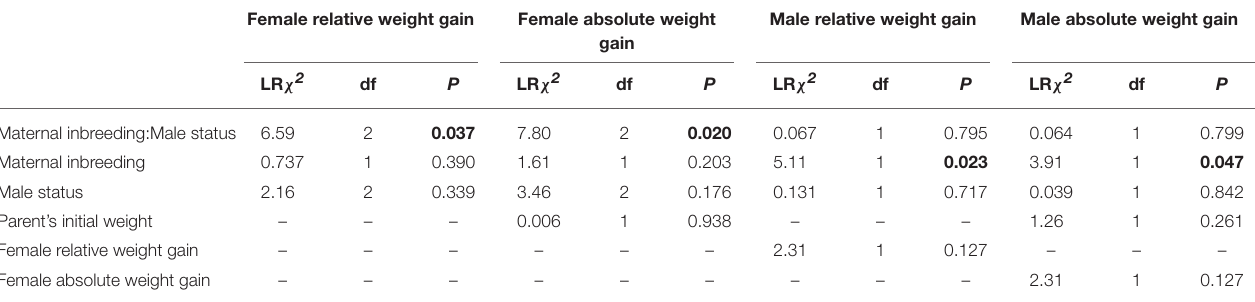
TABLE 2 | Effects of maternal inbreeding (inbred or outbred) and male status (inbred, outbred or absent) on female and male relative and absolute weight gains over the breeding attempt.